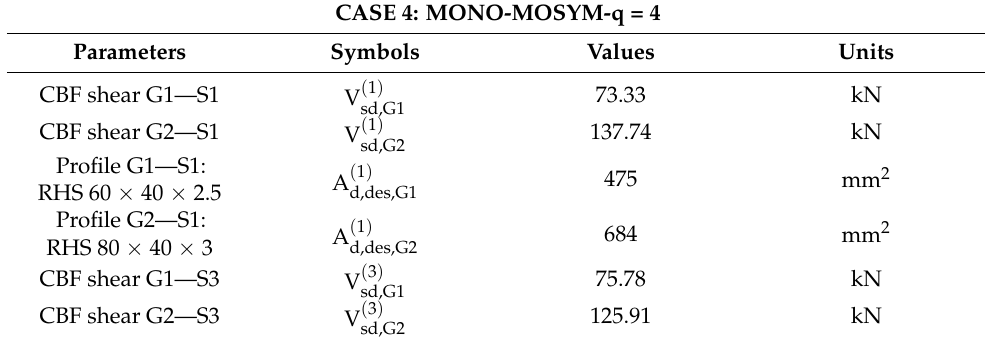
Table 9. Results of case study 3 (G: group; S: step).